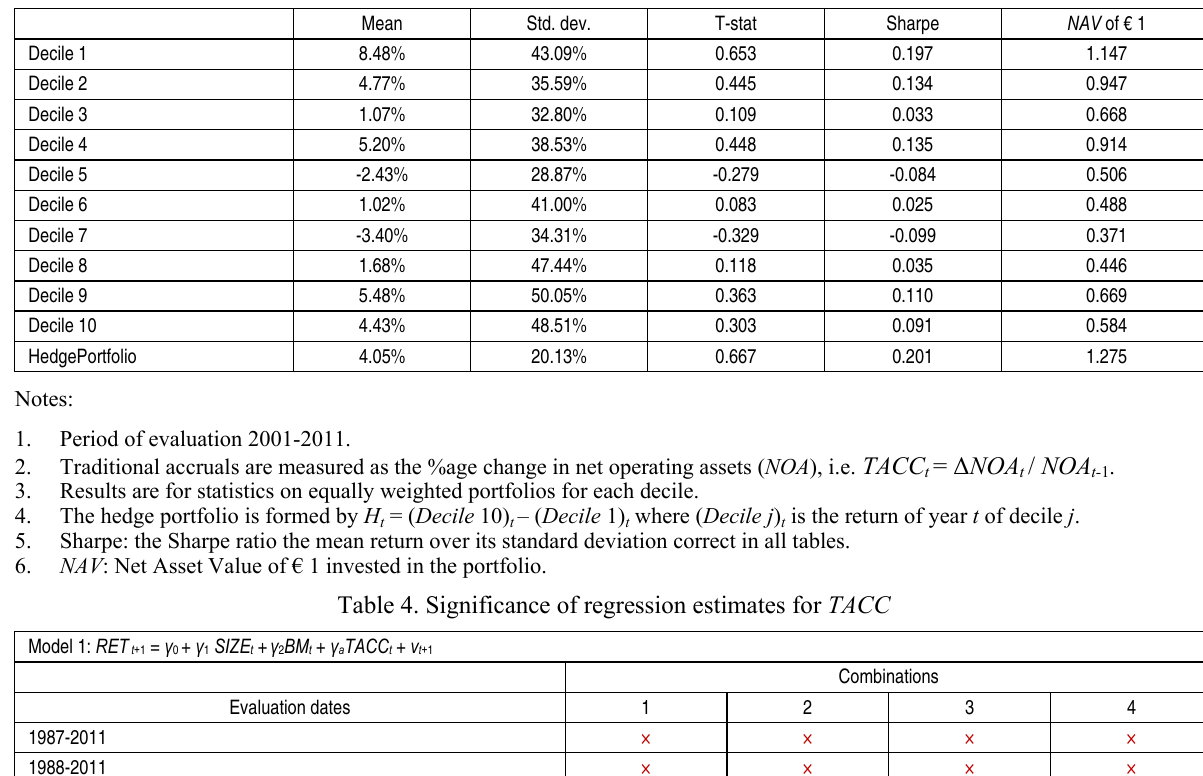
Table 3b. Performance statistics on accrual portfolios of % accruals